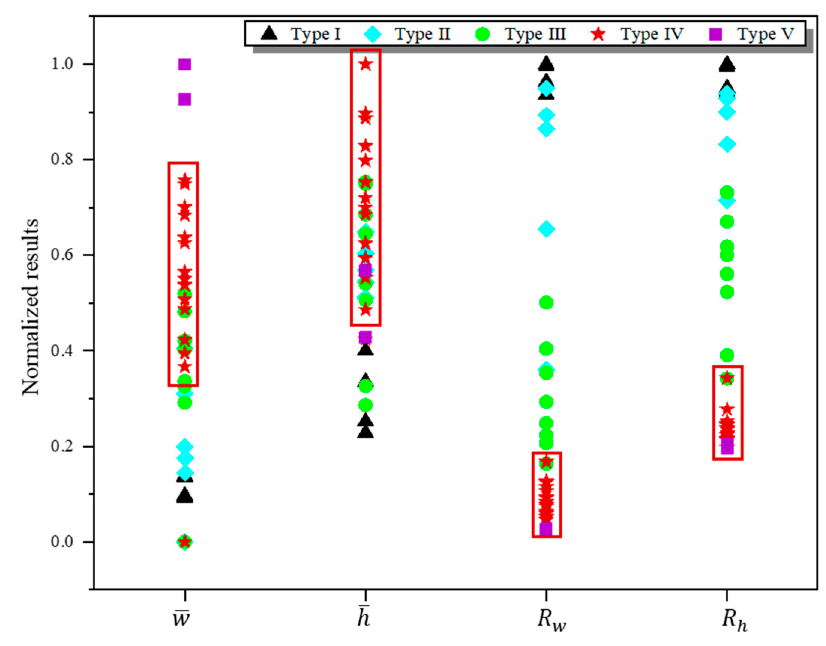
Figure 5. The normalized results of the four evaluation indicators which are served as the input variables of the NN model. The data for each indicator were normalized with dividing each variable by its maximum value. The sets of tracks of type IV were marked with red rectangle outlines. They possessed a small R w and R h , and a relatively large w and h . Table 1. The classification results of the tracks which are used as the target output of the NN model. As tracks of type Ⅳ had the potential to form parts with excellent performance, the combinations of laser power and scan speed at which they formed were marked as “1”, while other combinations as “0”.